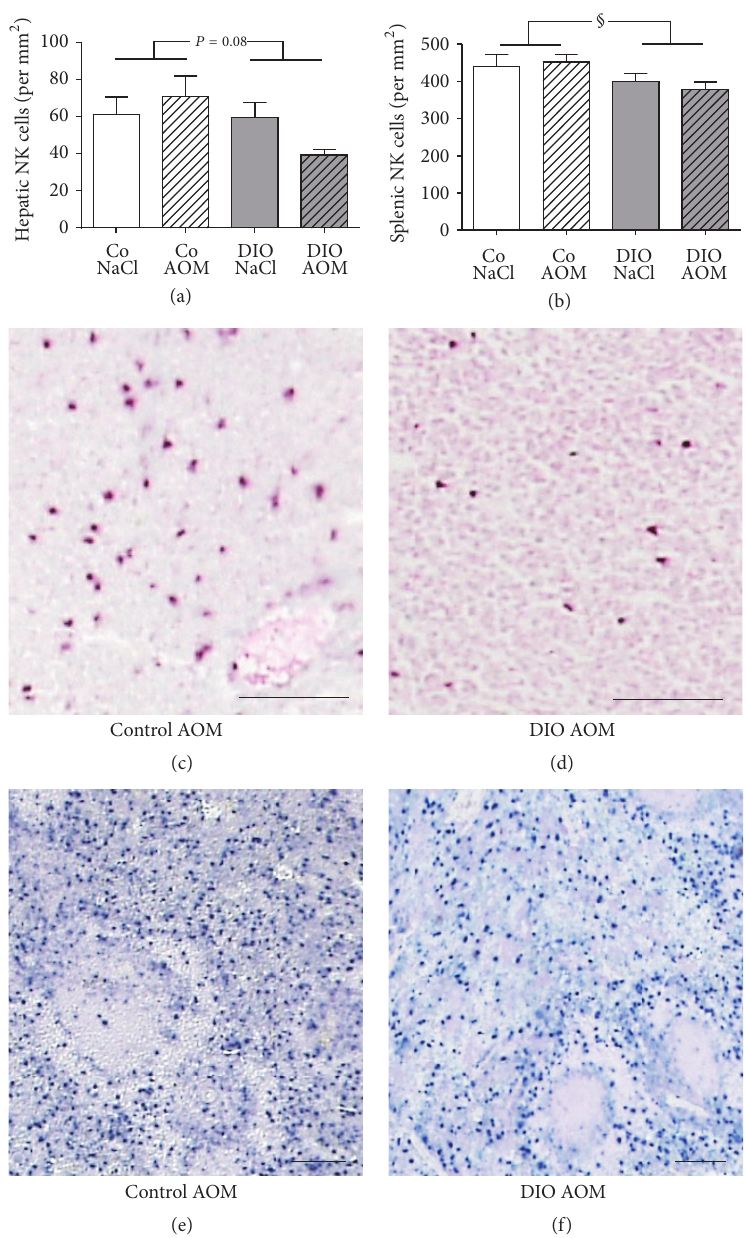
Figure 6: Numbers of NK cells in liver (a) and spleen (b) of normal weight [Co] and obese [DIO] rats treated with NaCl or azoxymethane (AOM). Data are expressed as mean ± SEM of 𝑛 = 5 animals per group. § 𝑃 < 0.05 , two-way-ANOVA, normal weight control groups compared to DIO groups. (c–f) Representative immunohistological detection of NK cells in liver tissue (red colored (c), (d)) and splenic tissue (blue colored; (e), (f)) in normal weight and obese rats treated with AOM (scale bar, 100 𝜇